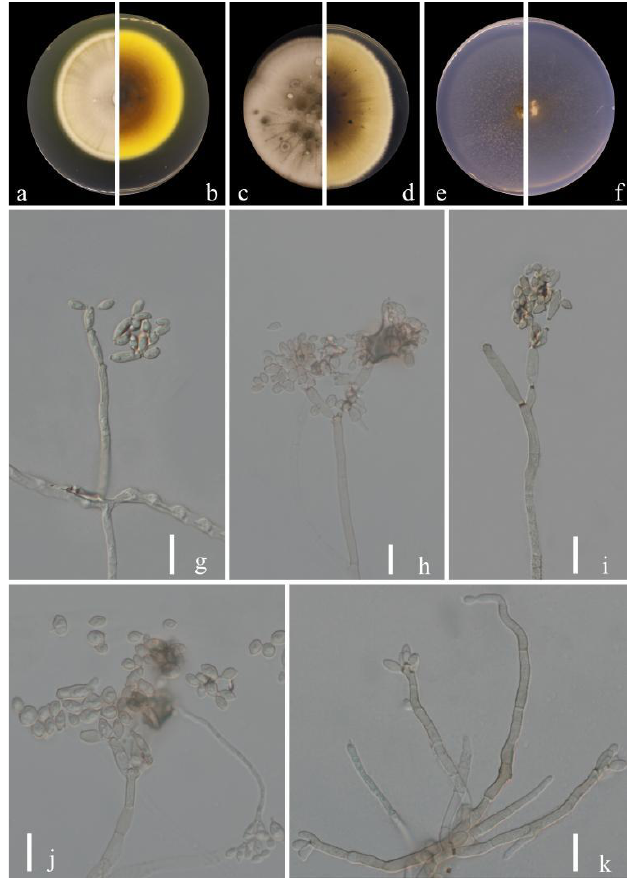
Figure 10. Cladosporium xanthochromaticum (GUCC 21267.1). ( a,b ) Culture on PDA from above